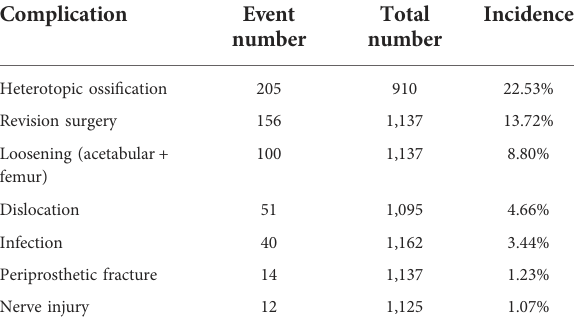
TABLE 3 Pooled complications after THA for PTOA following acetabular fracture.